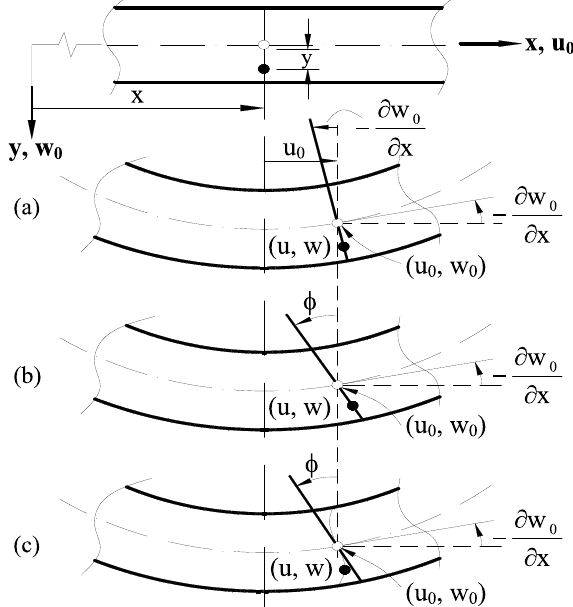
Fig. 1. Cross-section displacements in different beam theories [10]. a. Bernoulli-Euler Beam Theory (BET); b. Timoshenko Beam Theory (TBT); c. Reddy-Bickford Beam Theory